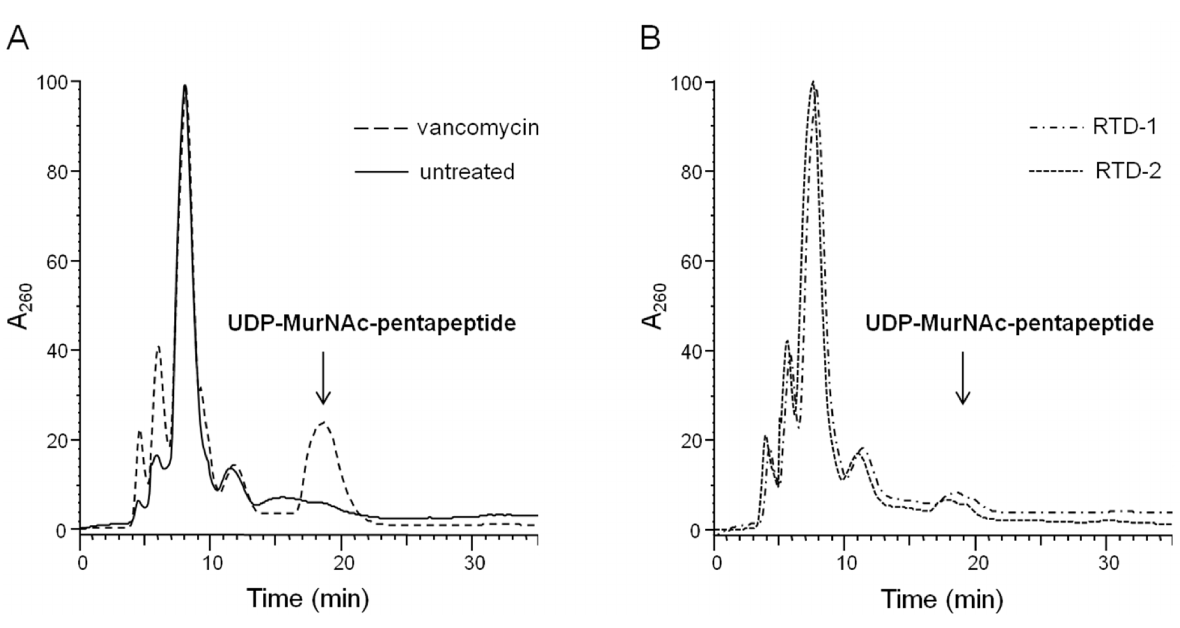
Figure 2. Intracellular accumulation of the final soluble cell wall precursor UDP-MurNAc- pentapeptide in S. simulans 22 exposed to θ-defensins. Cells were treated with 10× MIC vancomycin (positive control) (A) or RTDs (B), incubated for 30 min, and subsequently extracted with boiling water. The cytoplasmic pool of UDP-linked cell wall precursors was analyzed by